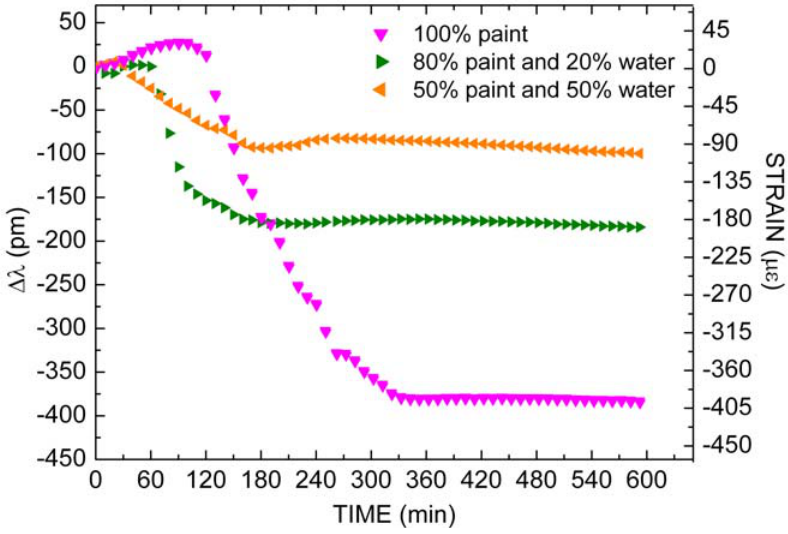
Figure 8. Packaged FBG4, FBG5 and FBG6 responses as function of time during the Paint2 drying process mixed with different water